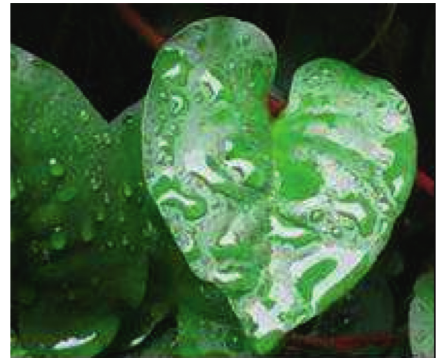
Figure 1: Binahong leaf ( Anredera cordifolia (Tenore) Steenis). Table 1: Effect of binahong extract on MDA levels on cataract